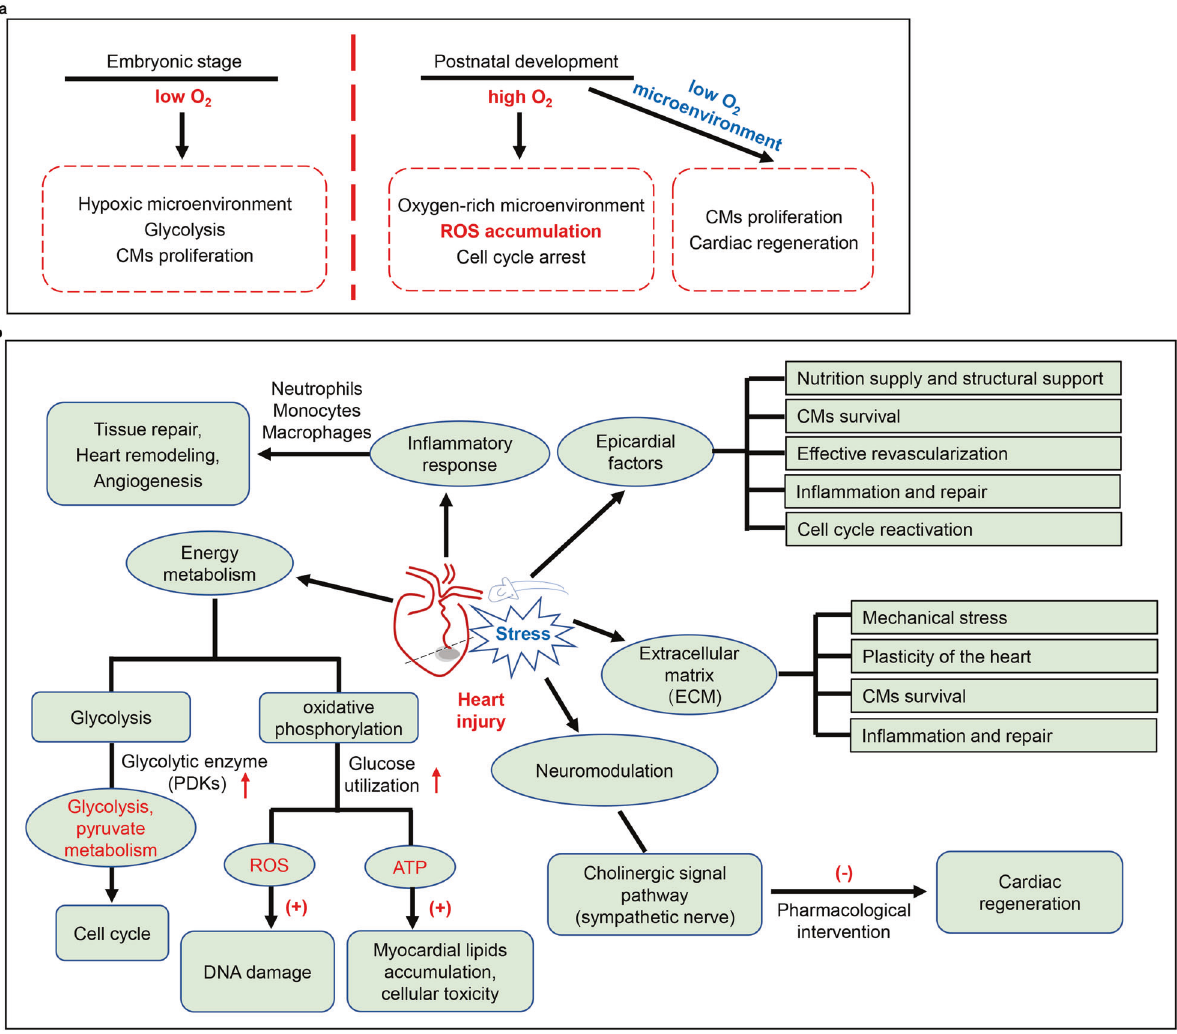
Fig. 2 Physiological and pathological factors involved in the regulation of cardiomyocyte proliferation. a Comparison of embryonic development and post-natal cardiac microenvironment (oxygenated state) on cell proliferation potential. b Under stress or injury, the changes in pathological microenvironment play a vital role in heart repair and cardiac regeneration. CMs cardiomyocytes, ECM extracellular matrix, ROS reactive oxygen species. ↑ : upregulate, ( + ): promote, (-):